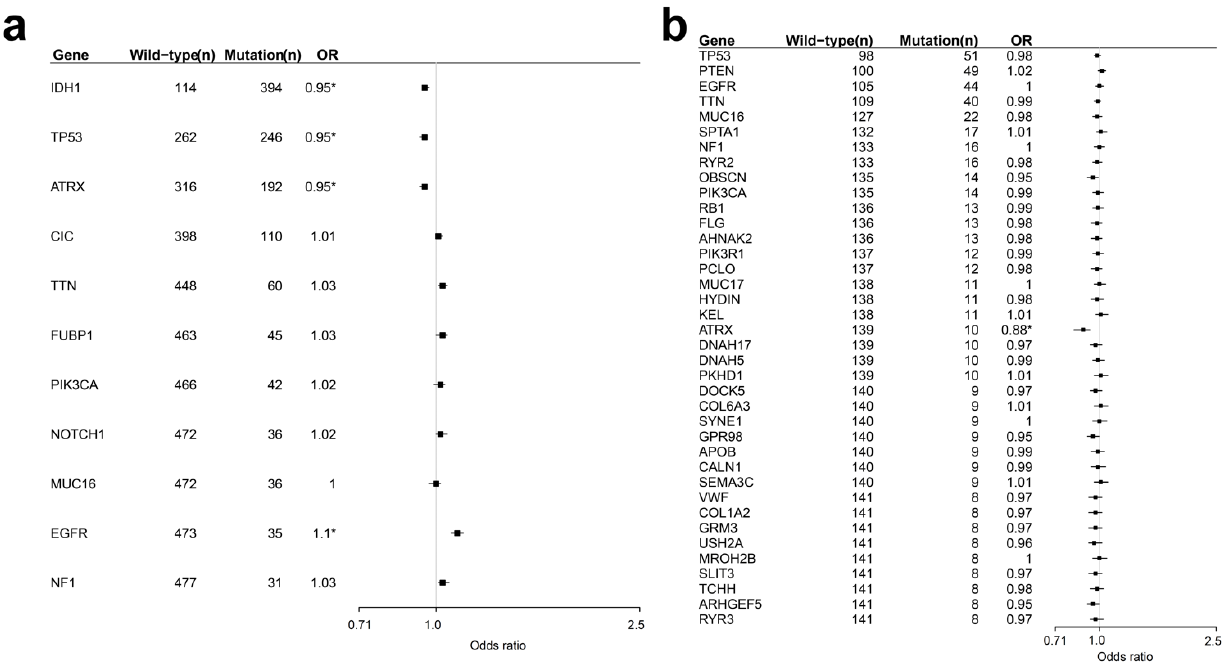
Figure 1. Frequencies of mutated and wild-type genes and logistic regression results showing the relationship of mutations with age in patients with lower grade glioma ( a ) and glioblastoma ( b ). Genes shown have mutation rates >5%. OR, odds ratio; *, significant.